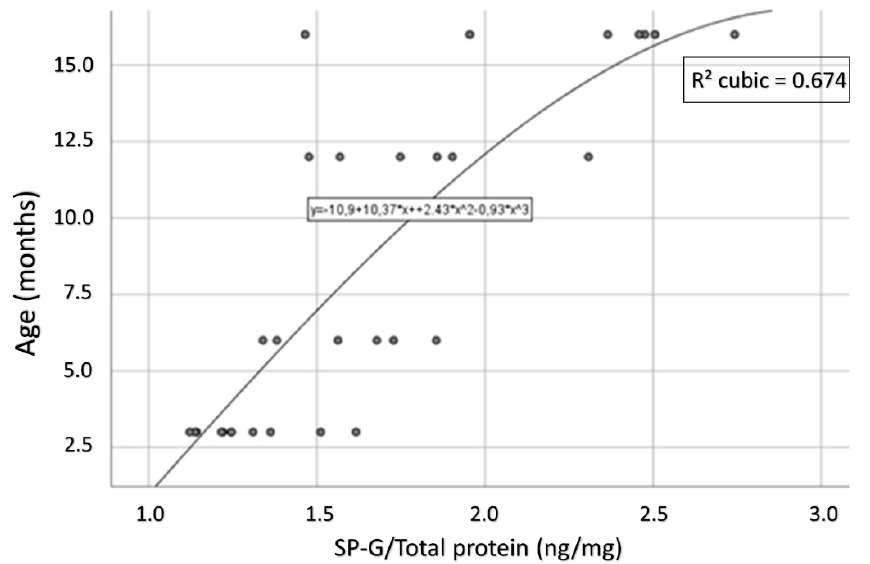
Figure 13. Representation of the correlation between age and intracellular SP-G content in 3xTg mice. This correlation is strong and statistically significant (Spearman’s ρ = 0.831, p < 0.001).